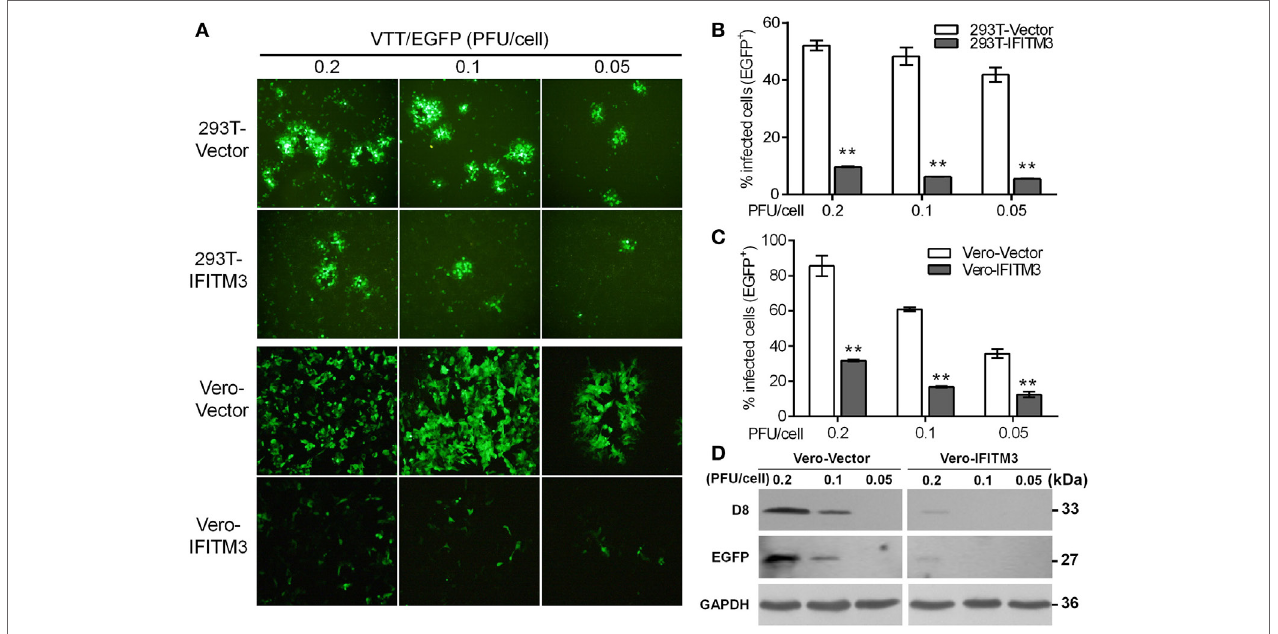
FigUre 3 | Inhibitory effect of overexpression of interferon-inducible transmembrane protein 3 (IFITM3) on vaccinia virus (VACV) infection. (a) Fluorescent plaques formed by vaccinia virus Tian Tan green fluorescent protein (VTT-EGFP) in IFITM3-overexpressed 293T and Vero cells observed via fluorescence microscope. (B,c) Quantitative analysis of EGFP-positive cells infected by VTT-EGFP was determined by flow cytometry. Values represent the mean ± SD of at least three independent experiments. ** P < 0.01. (D) Expression of viral D8 and EGFP proteins in Vero cells expressing IFITM3 or vector infected with VTT-EGFP was measured by Western blot.